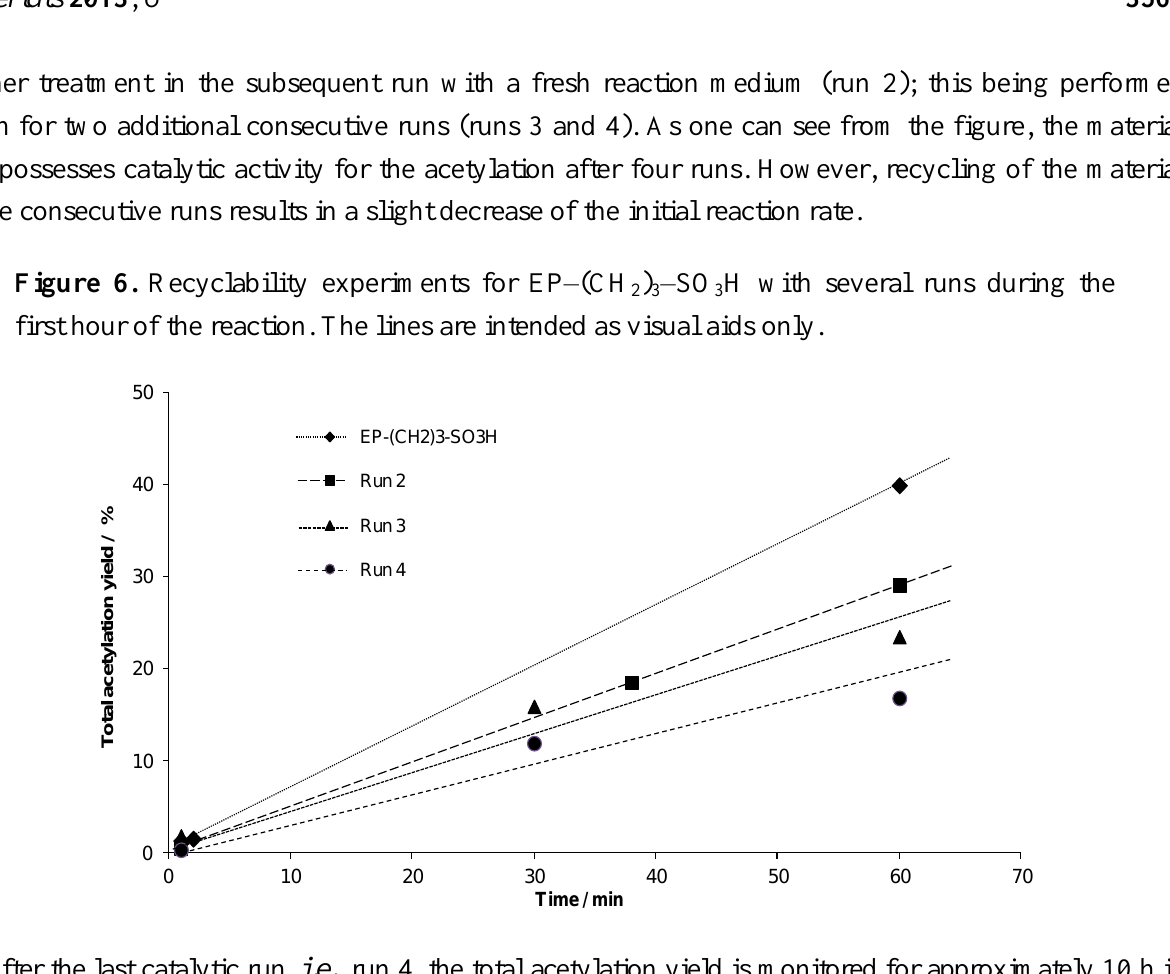
) –SO H with several runs during the 2 3 3